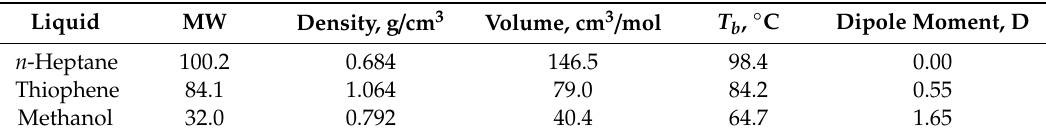
Table 4. Physical properties of the studied liquids.